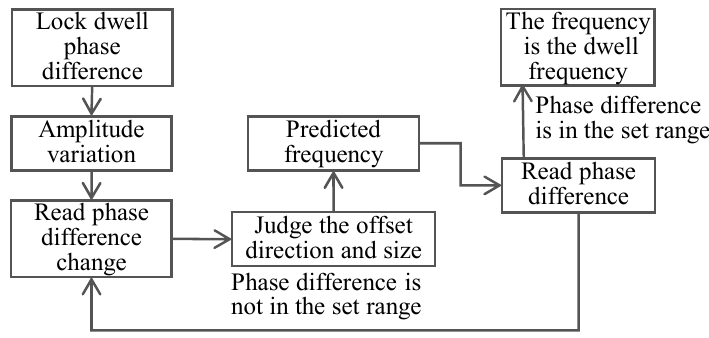
Figure 6. Iterative frequency resonance tracking method.